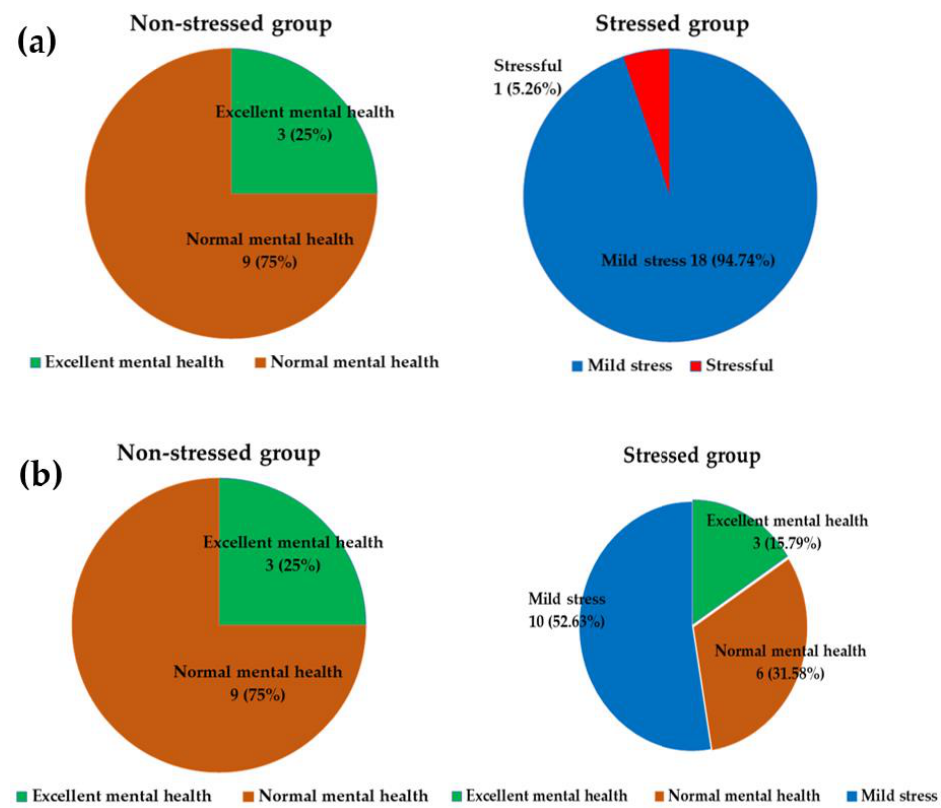
Figure 2. Stress status of the stressed and non-stressed groups (numbers of subjects (%)). The different color denotes each stress status. Green: Excellent mental health; Orange: Normal mental health; Blue: Mild stress; Red: Stressful. ( a ) Stress status at baseline, ( b ) Stress status after 12 weeks. At baseline, the stressed group (13.53 ± 1.20) expressed a statistically significant high scale score on negative feelings compared with the non-stressed group (2.33 ± 0.54) ( p < 0.001). In contrast, there was no statistical difference in the positive scale scores (Figure